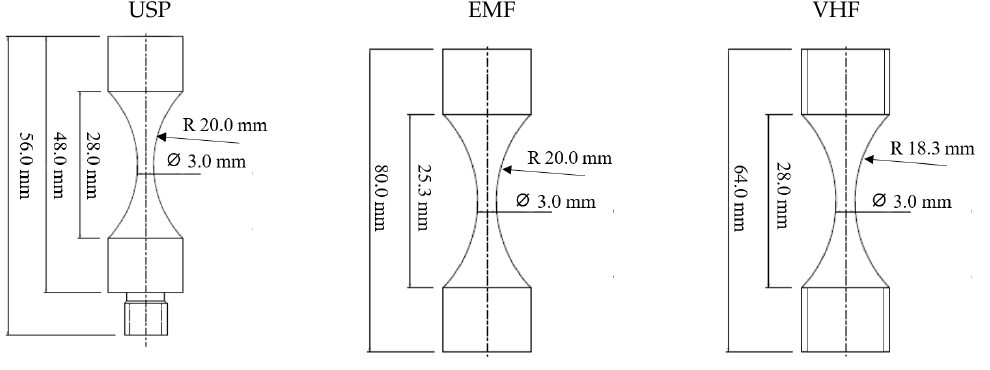
Figure 1. Geometry of specimens with ultimate tensile strength 919 MPa and K = 1